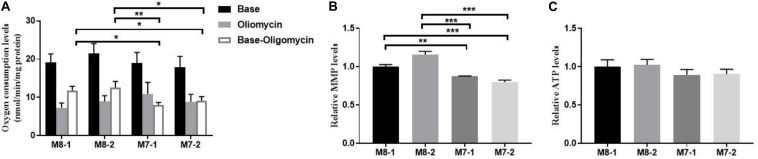
Mitochondrial function is lower in M7 cybrids than M8 cybrids. (A) Mitochondrial respiratory capacities were determined in M8 and M7 cybrids. Oligomycin (2.5 μg/mL) was added for the measurement of uncoupled mitochondrial respiration. OXPHOS coupling respiration was calculated by subtracting the uncoupled component value from the total endogenous respiration value. (B) MMP was determined in M8 and M7 cybrids treated with 30 nM tetramethylrhodamine (TMRM) for 20 min. Relative MMP levels were normalized to M8-1 cybrid. (C) ATP was determined in M8 and M7 cybrids with boiled cells. Relative ATP levels were normalized to M8-1 cybrid. Data are shown as the mean ± SD from at least three independent tests per experiment. *P < 0.05; **P < 0.01, ***P < 0.001.